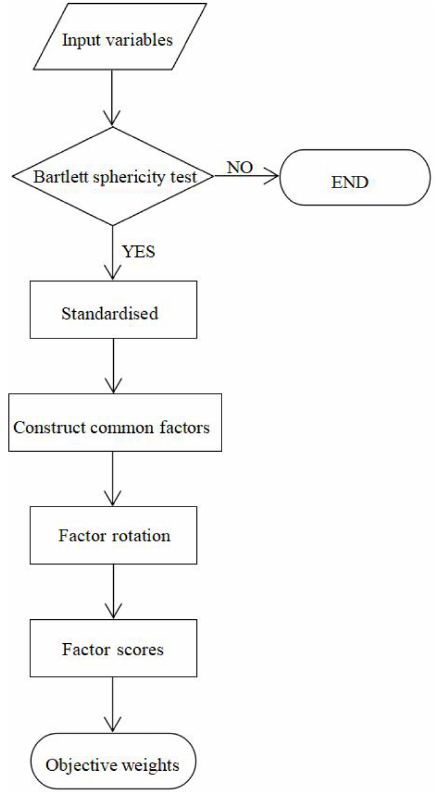
Figure 7. A flowchart of